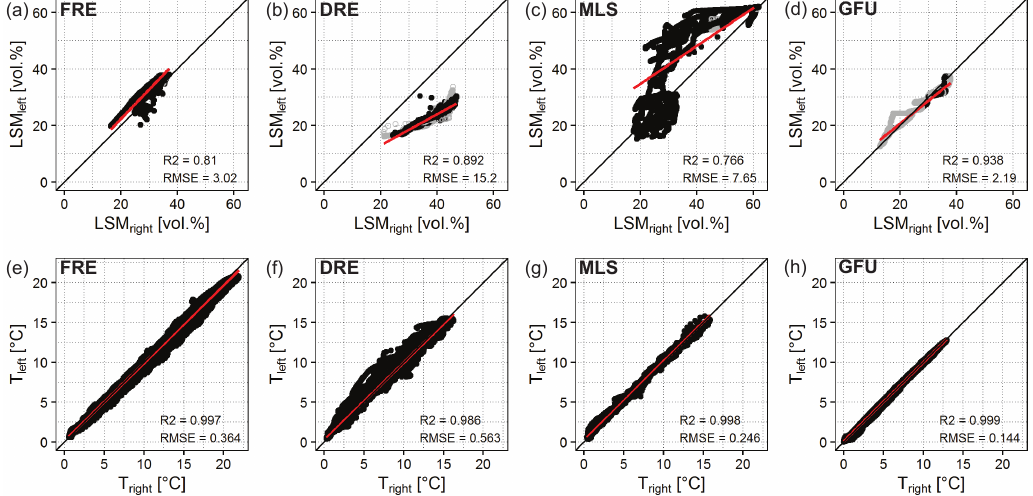
Figure 4. Comparison of measured LSM (upper row) and ground temperature (lower row) from both SMT100 sensors at 30cm depth using the linear calibration at FRE (a, e) , DRE (b, f) , MLS (c, g) and GFU (d, h) . The hollow grey points represent LSM measurements taken when the ground temperature was below 1 ◦